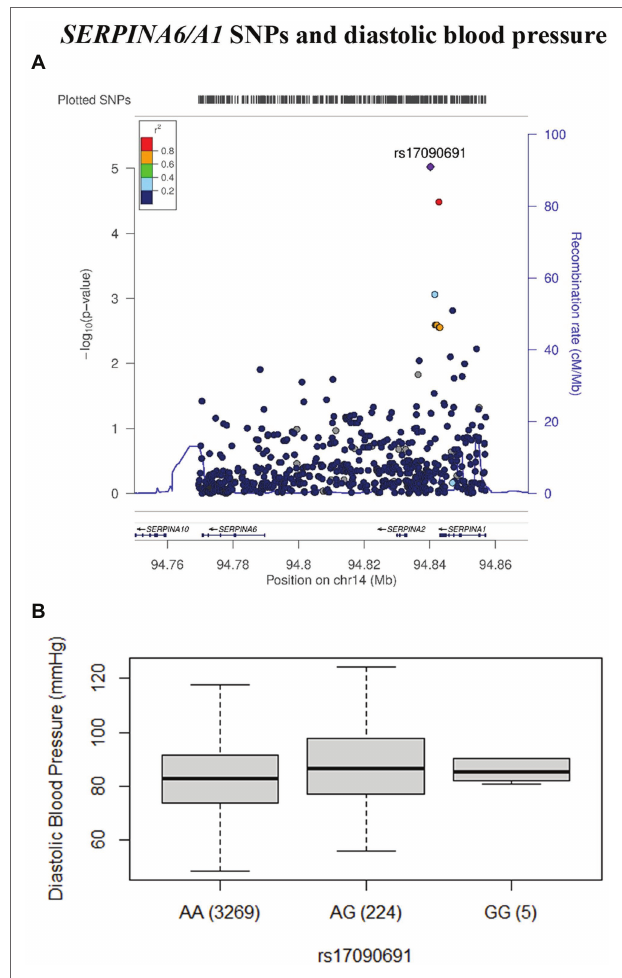
FIGURE 2 | The association between rs17090691 and diastolic blood pressure in black South African men and women. The LocusZoom (A) plot association data was plotted using the AFR LD backgrounds from the 1,000 Genomes Project phase 1 dataset. The rs17090691 single nucleotide polymorphism (SNP) is represented by a purple diamond. Each SNP is colored according to the r 2 value against rs17090691. SNPs with missing LD information are colored in gray. The box and whisker plot (B) shows medians and interquartile ranges (IQRs) of diastolic blood pressure across the rs17090691 genotype groups. The number of observations in each group is shown in